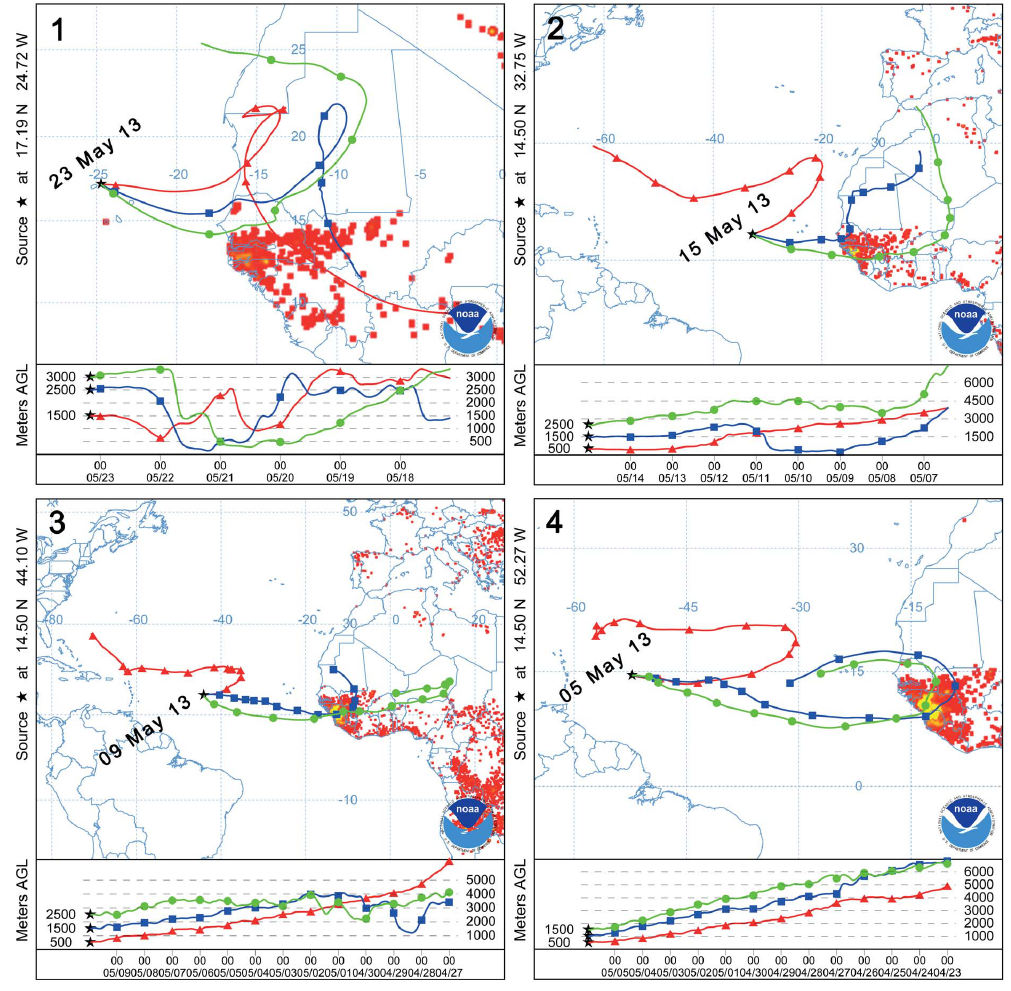
Figure 5. The 5-day to 13-day HYSPLIT backward trajectories for 23 May 2013, 04:00UTC (case 1), 15 May 2013, 00:00UTC (case 2), 9 May 2013, 23:00UTC (case 3), and 5 May 2013, 23:00UTC (case 4). Symbols indicate air mass transport from day to day. The arrival height level of 500m (red) is in the MAL. Arrival heights of 1500–3000m (blue, green) are in the SAL. In addition, fires (red dots) detected by MODIS aboard the Terra and Aqua satellites are shown accumulated over a 10-day period (21–30 April 2013 for cases 3 and 4, 11–20 May 2013 for case 2, and 21–30 May 2013 for case